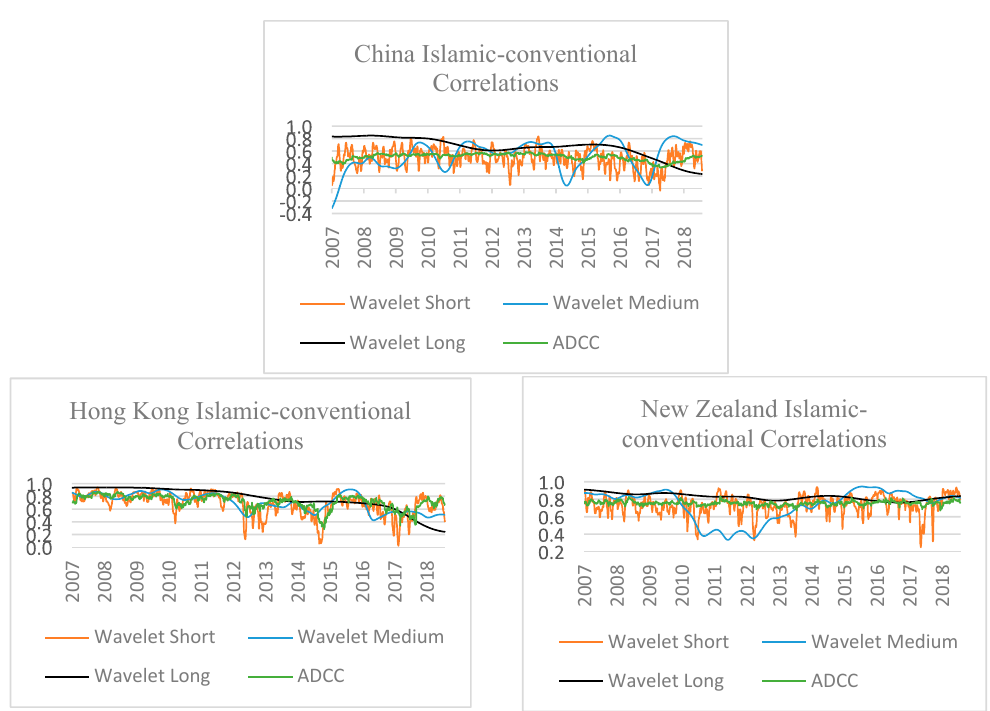
Figure 4. Wavelet short-, medium-, long-term and ADCC correlations for Asian/Pacific Islamic and conventional equity markets.